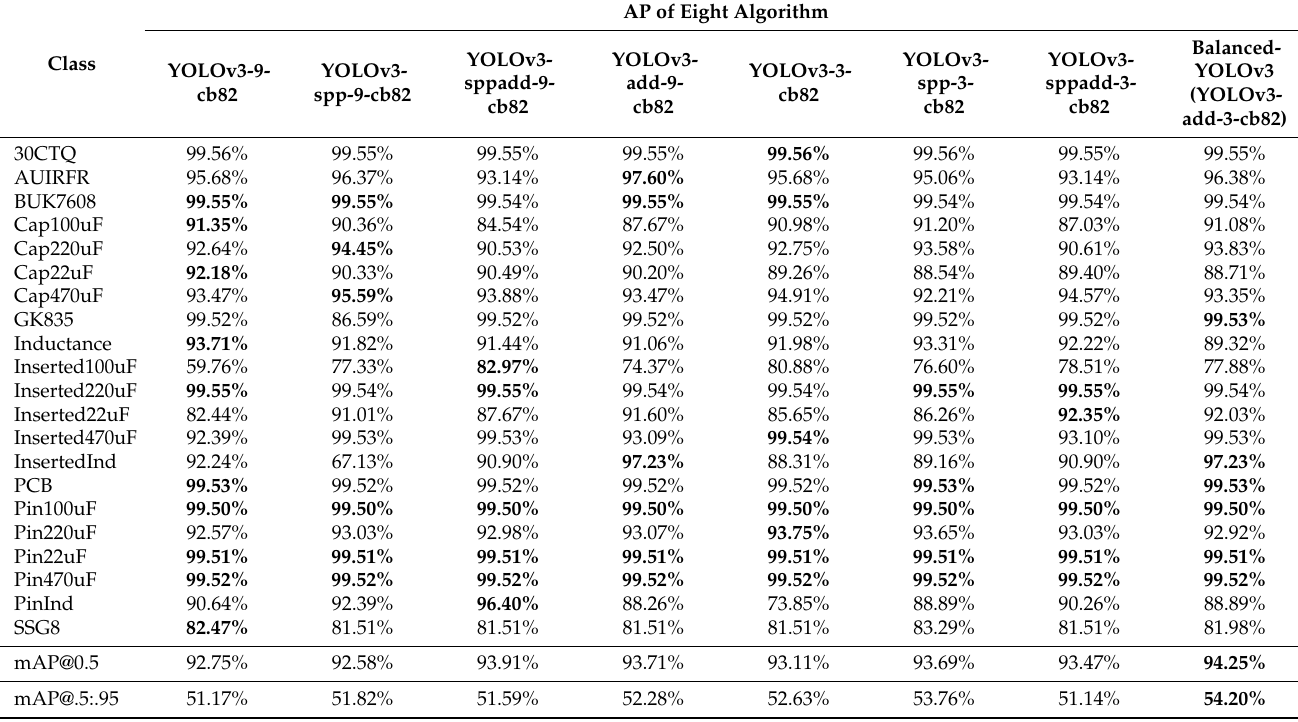
Table 5. AP, mAP@.5, and mAP@.5:.95 of eight algorithms based on Train/Val